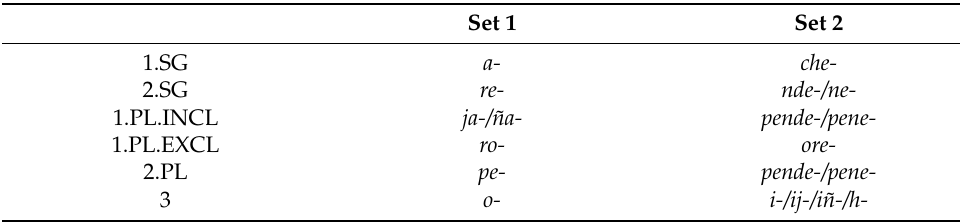
Table 1. Mbya Guarani argument indexation